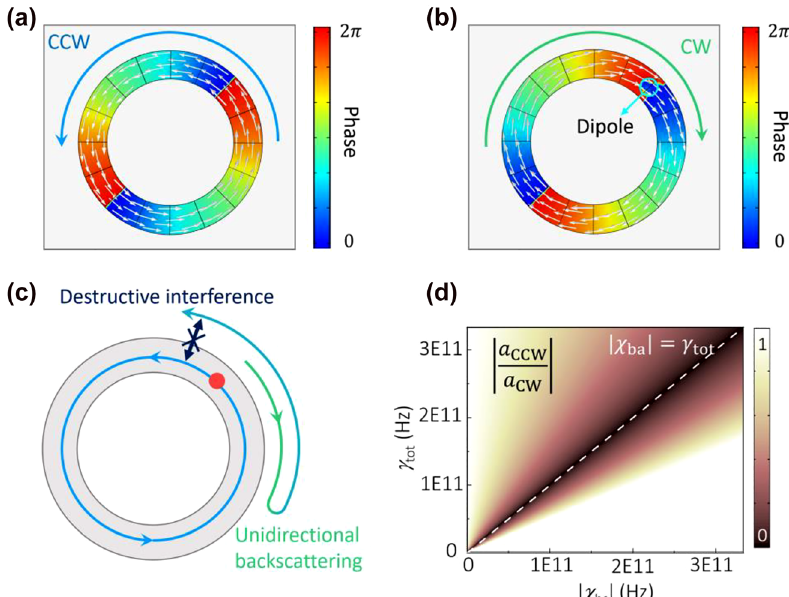
Figure 2: Anomalous spontaneous emission at exceptional point. (a) and (b) Phase distribution of the radial electric field E ρ of the coalesced eigenmode (a) and the single emitter excited mode (b). The white arrows denote Poynting vectors. (c) The anomalous spontaneous emission effect is due to the completely destructive interference between the directly radiated CCW wave andthe backscattered CCW wave. (d)AmplituderatiobetweentheCCWandCW waves in the radiation fi eld. Anomalous spontaneous emission effect occurs when χ = − γ ba tot